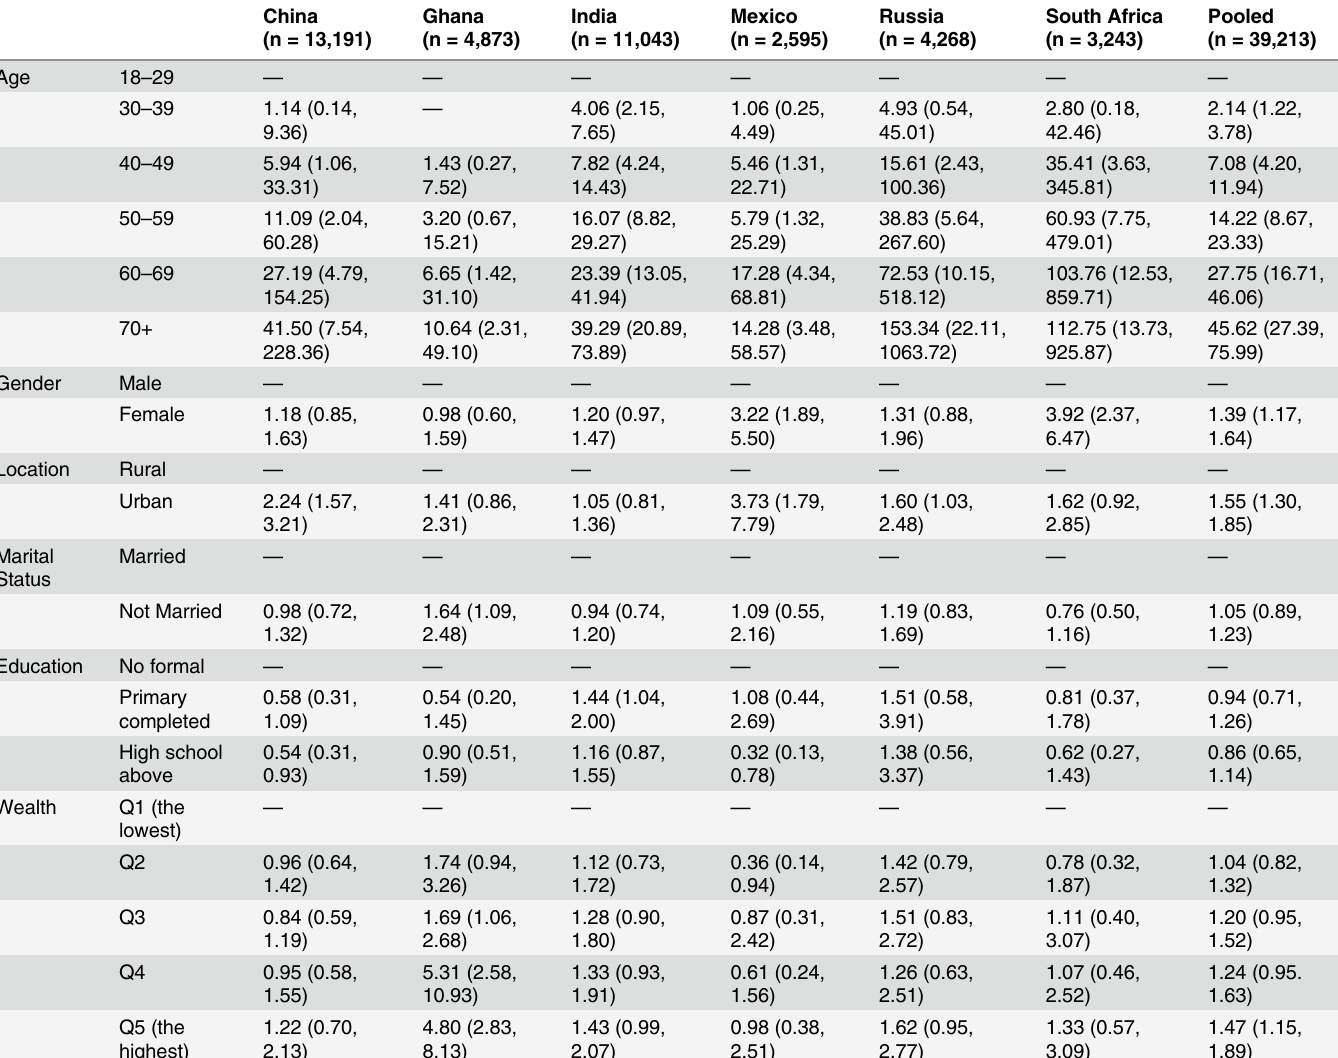
Table 1. Socio-demographic correlates of multimorbidity in SAGE